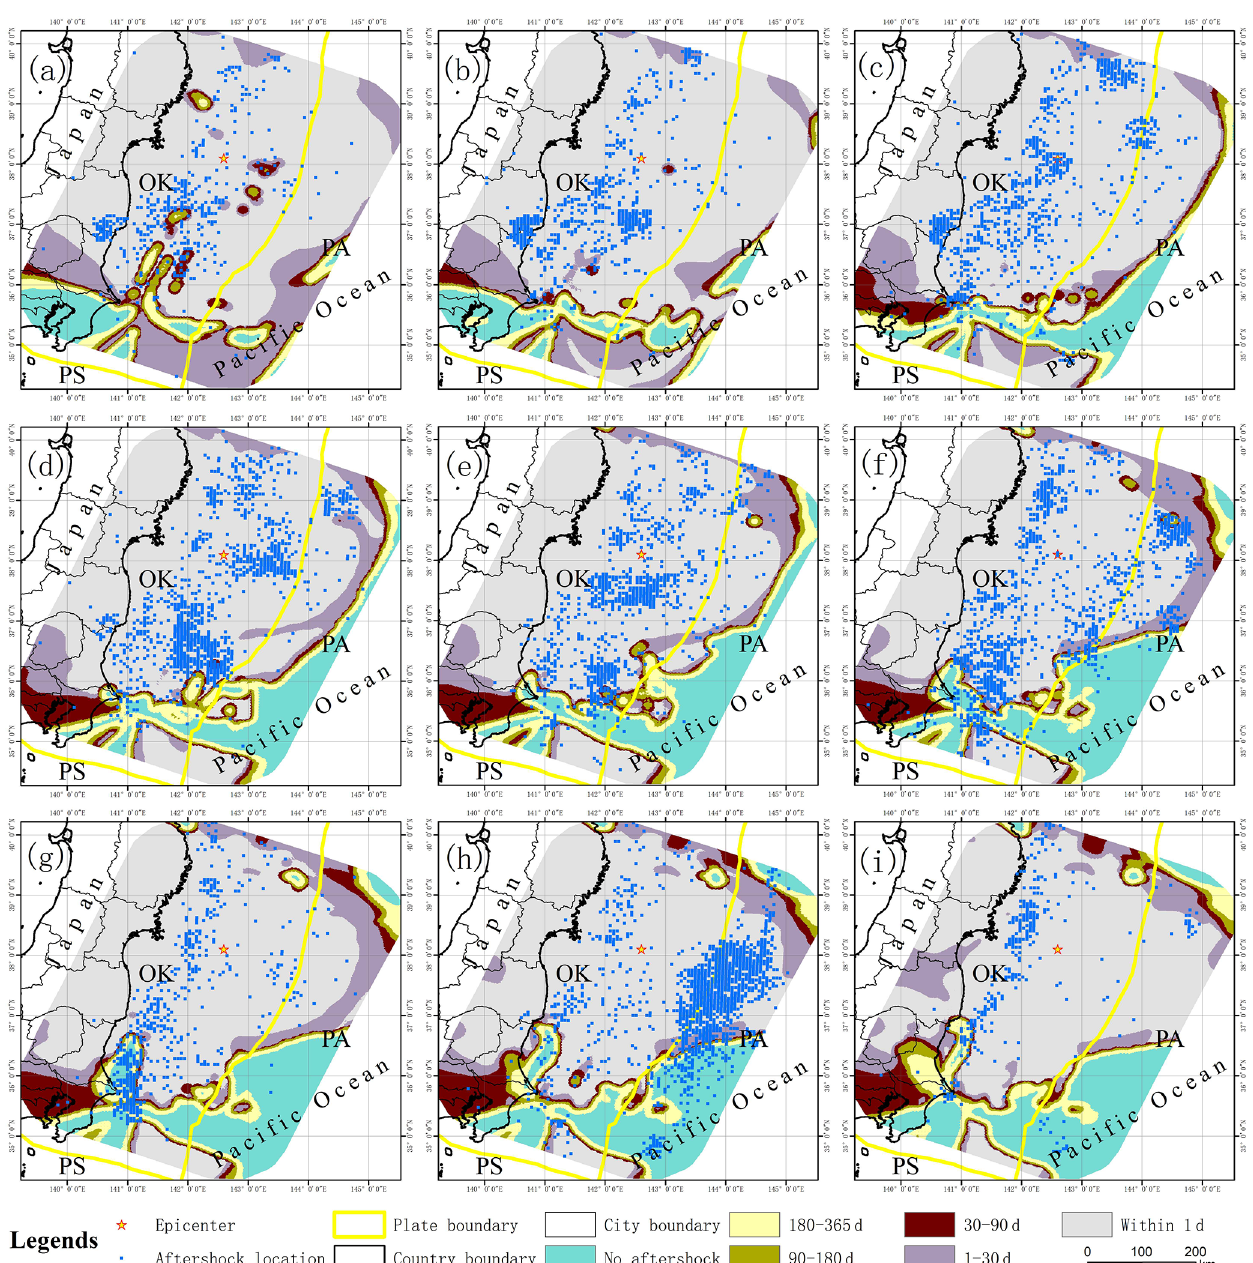
Figure 12. Aftershock hysteresis effect of the Tohoku earthquake at different depths. Panels (a) through (i) show the aftershock hysteresis effect of the Tohoku earthquake for depth sections of 2.5, 7.5, 12.5, 17.5, 22.5, 27.5, 32.5, 37.5 and 42.5km,